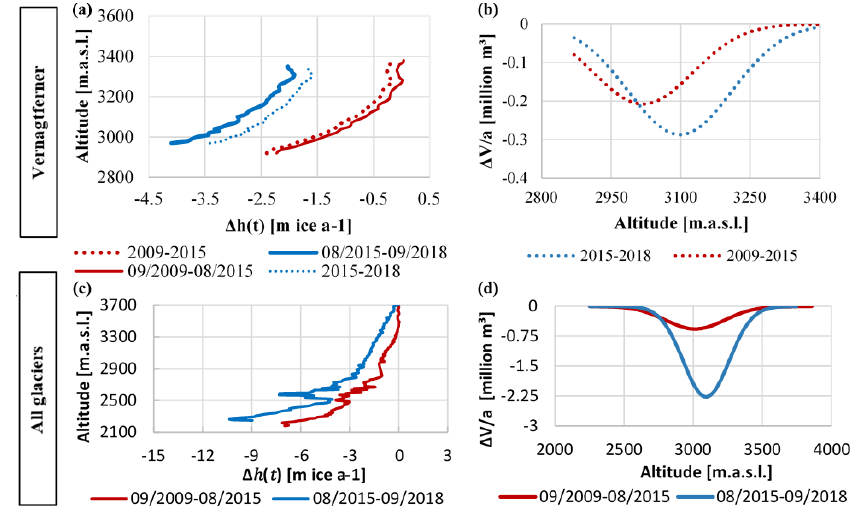
Figure 7. Annual height changes (cid:49)h(t) per altitude for the Vernagtferner (a) and all glaciers (c) ; annual volume changes for the Vernagtferner (b) and all glaciers (d) ; dotted lines represent the surface or volume changes after the correction of the acquisition